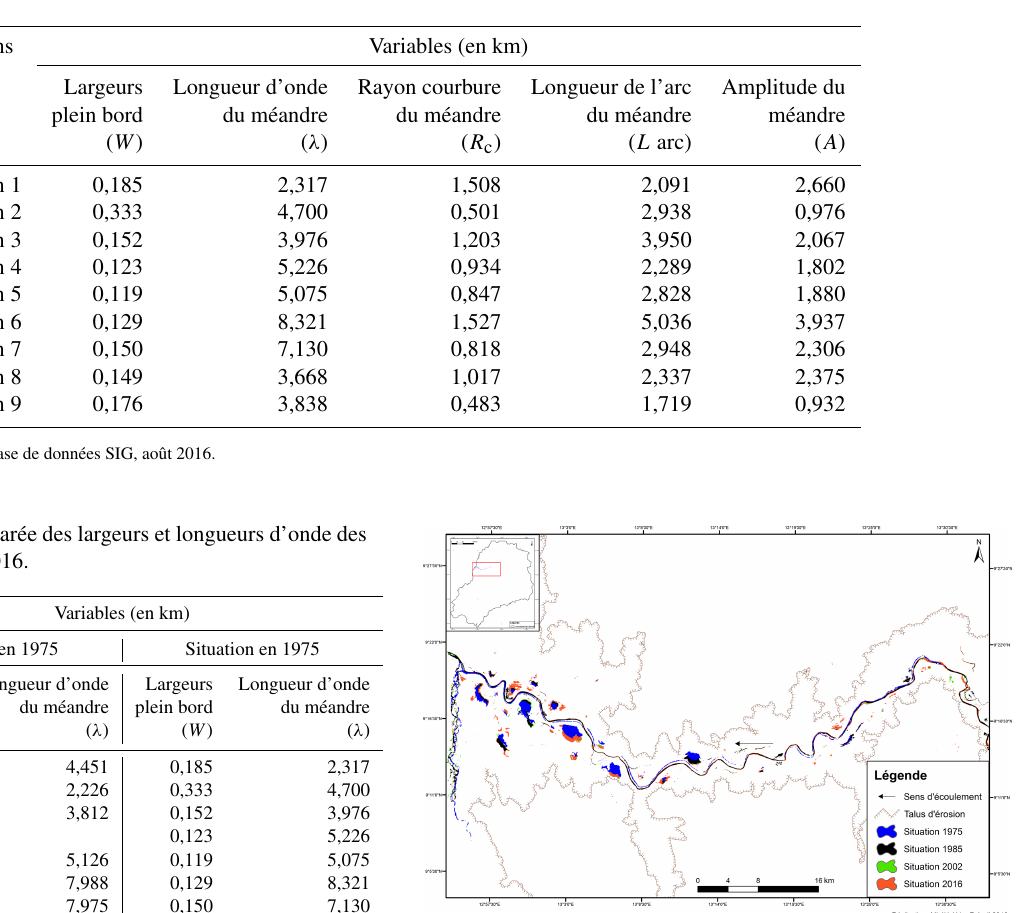
Tableau 2. Caractéristiques morphométriques des méandres en 2016.